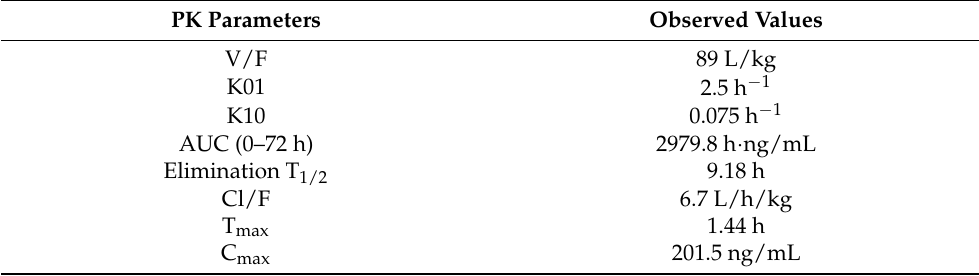
Figure 7. Pharmacokinetic profile of RIDR-PI-103 ( A , B ). A single dose of RIDR-PI-103 (20 mg/kg) was administered intraperitoneally in mice and serial blood samples were collected over a period of 96 h ( n = 3 per time point). Concentration- time profile for RIDR-PI-103 in mice plasma using one-compartmental and non-compartmental analysis. Table 1. The key PK parameters for the plasma concentration-time profile fitted a one-compartment model for RIDR-PI-103.